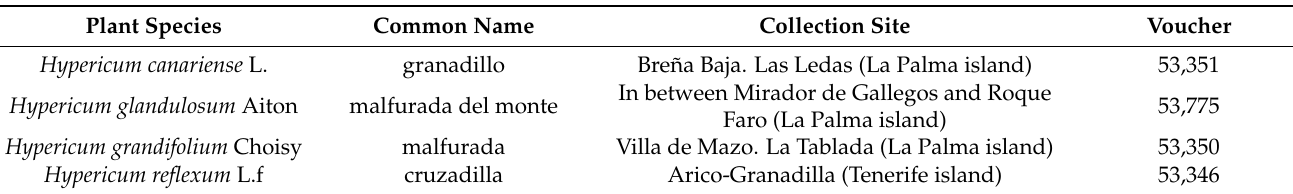
Table 4. Collection data of four Hypericum